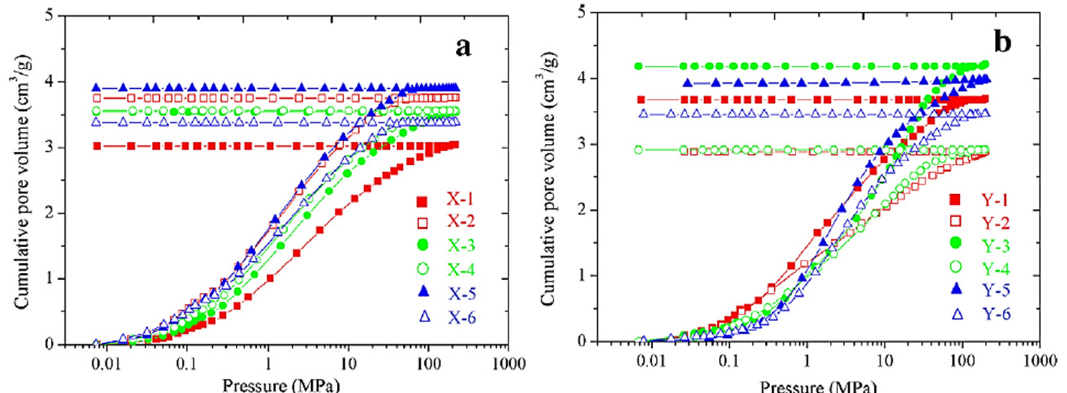
Figure 5. Effect of mercury pressure on specific cumulative pore volume of ( a ) X (80:20 ethanol/H 2 O) and ( b ) Y (50:50 ethanol/H 2 O SiO 2 aerogels. Reprinted with permission from [74].